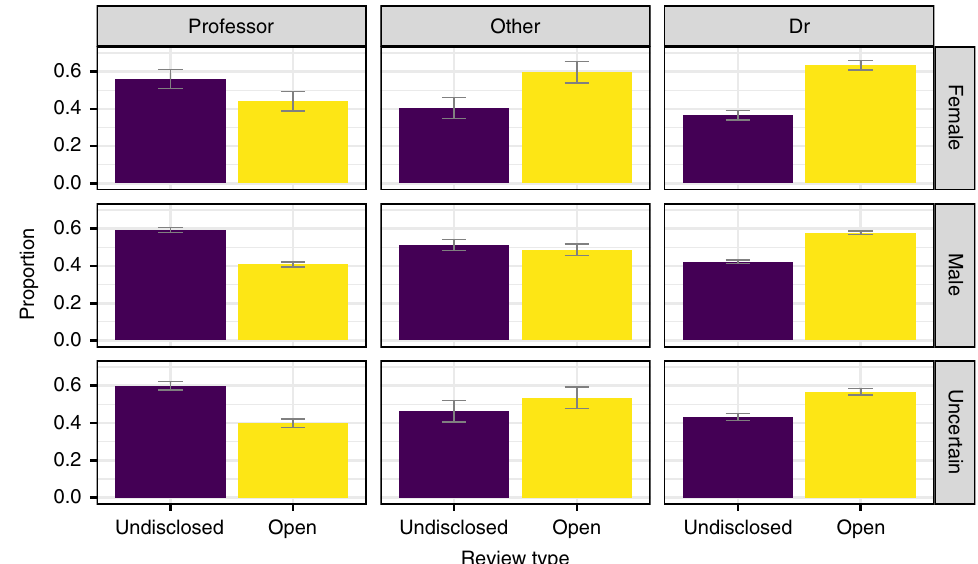
Fig. 3 Gender and status distribution of referees by review condition. Error bars represent 95% CI obtained via bootstrap (1000 samples) NATURE COMMUNICATIONS| (2019) 10:322